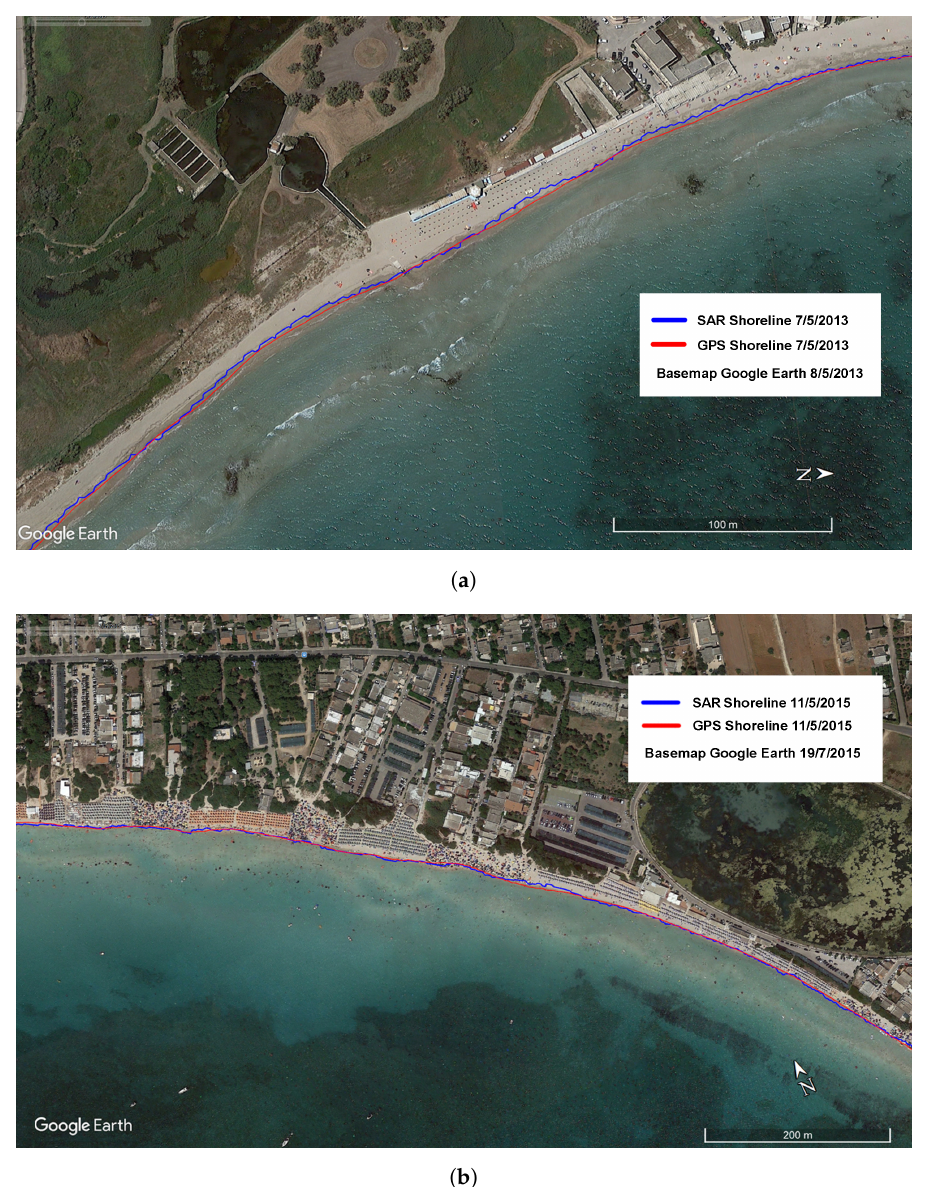
Figure 7. Accuracy assessment of SAR extracted shoreline: ( a ) Test site I; ( b ) Test site II.